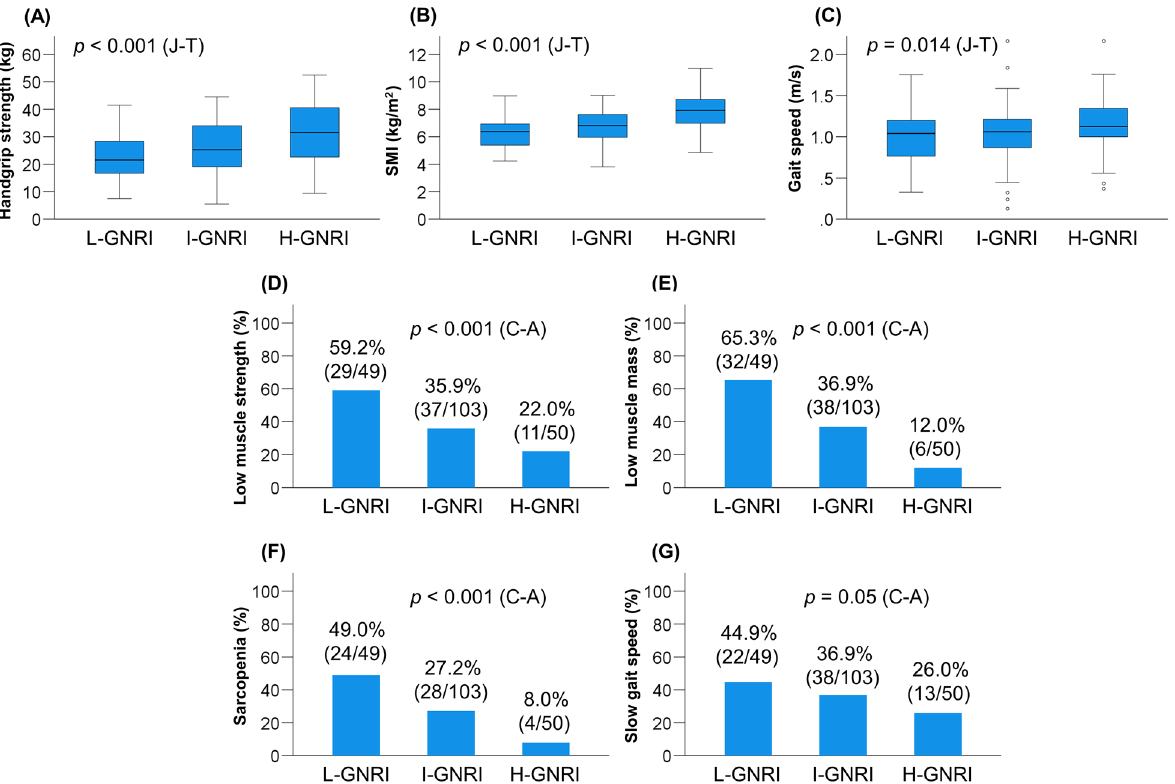
Figure 1. Comparison of clinical characteristics among the low-Geriatric Nutritional Risk Index (L-GNRI), intermediate-GNRI (I-GNRI), and high-GNRI (H-GNRI) groups. ( A ) Handgrip strength ( p < 0.001), ( B ) skeletal muscle mass index (SMI; p < 0.001), and ( C ) gait speed ( p = 0.014) significantly decreased stepwise with decreasing GNRI values. ( D – G ) The L-GNRI group had the highest prevalence of low muscle strength (59.2%), low muscle mass (65.3%), sarcopenia (49.0%), and slow gait speed (44.9%), while the H-GNRI group had the lowest prevalence of low muscle strength (22.0%), low muscle mass (12.0%), sarcopenia (8.0%), and slow gait speed (26.0%). A stepwise increase in the prevalence of these complication was observed with decreasing GNRI values ( p = 0.05 for slow gait speed; p < 0.001 for all the rest). J–T Jonckheere–Terpstra test, C–A Cochran– Armitage